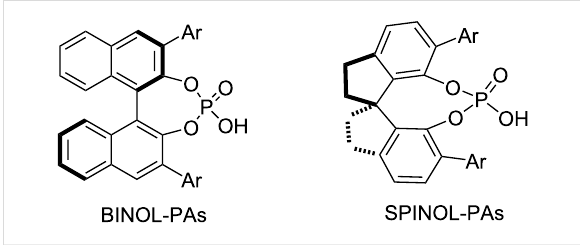
Figure 4: Important chiral phosphoric acid scaffolds used in this